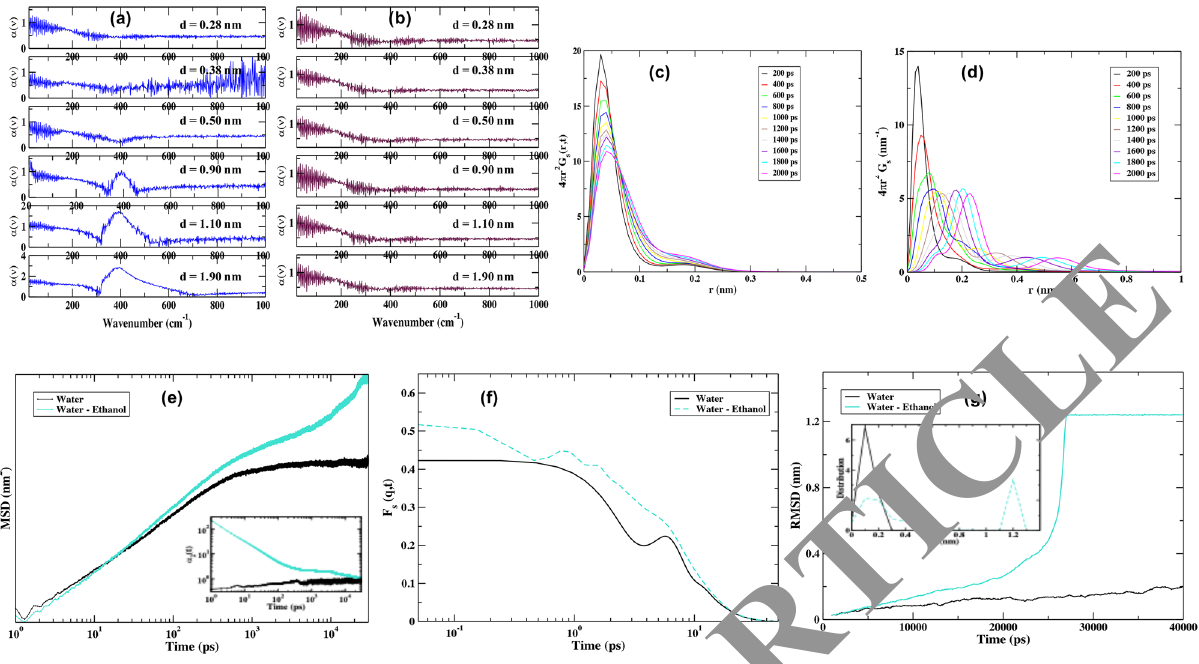
Figure 14. ( a ) The calculated distance dependent absorption coefficient of water in the nA6 complex hydration shell from the MD simulation in pure water and ( b ) in the water–ethanol solvent mixture. The van Hove self- correlation function of the antibody complex in ( c ) water and ( d ) in the water–ethanol mixed solvent from MD simulation. ( e ) The calculated MSD of the nA6 complex in water (black) and in the water–ethanol mixed solvent (cyan) from MD simulation. The inset in ( e ) shows the plot of the non-Gaussian parameter (α 2 (t)) in both samples. ( f ) The short and intermediate time scale of the calculated self ISF of the antibody complex in water (black) and in the mixed solvent (cyan) from MD simulation. ( g ) Representative RMSD of the MD simulations carried out on the nA6 complex in water (black line) vs that in the water–ethanol solvent (cyan line). The inset in ( g ) shows the C-α distribution of distances from calculation of the RMSD in the